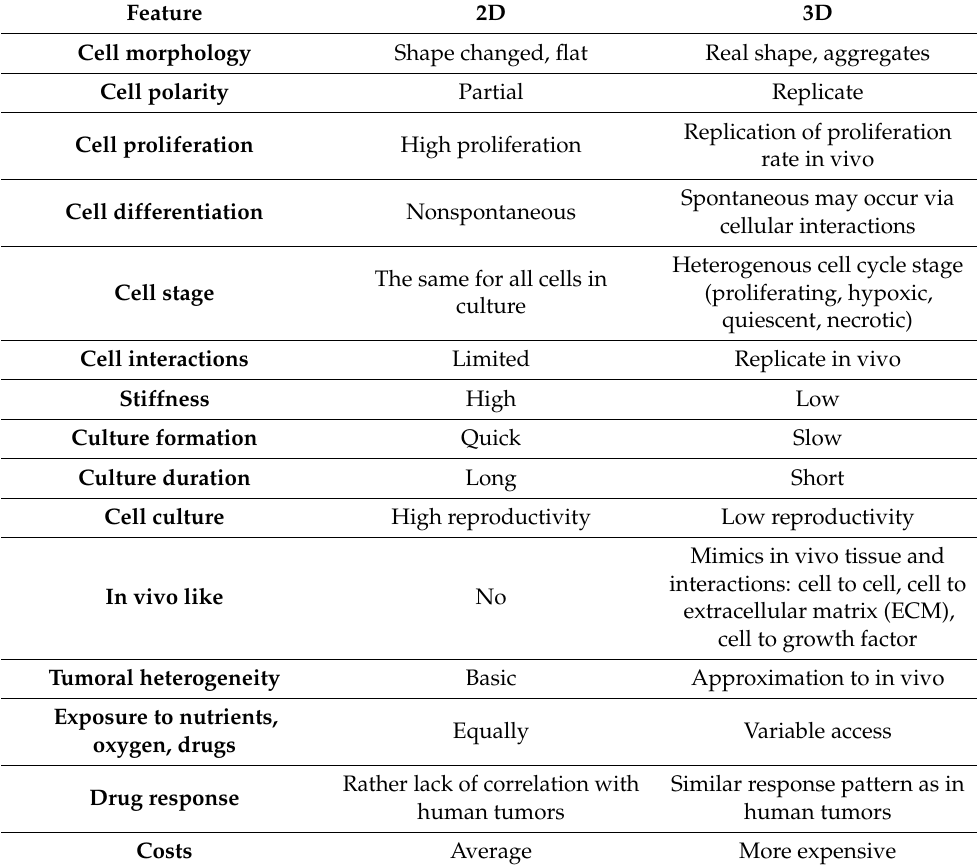
Table 1. Difference between two-dimensional (2D) and three-dimensional (3D) cell